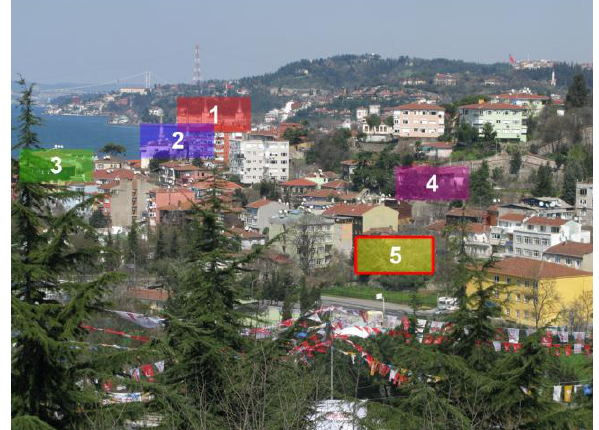
Figure 6. The actual photograph and control points